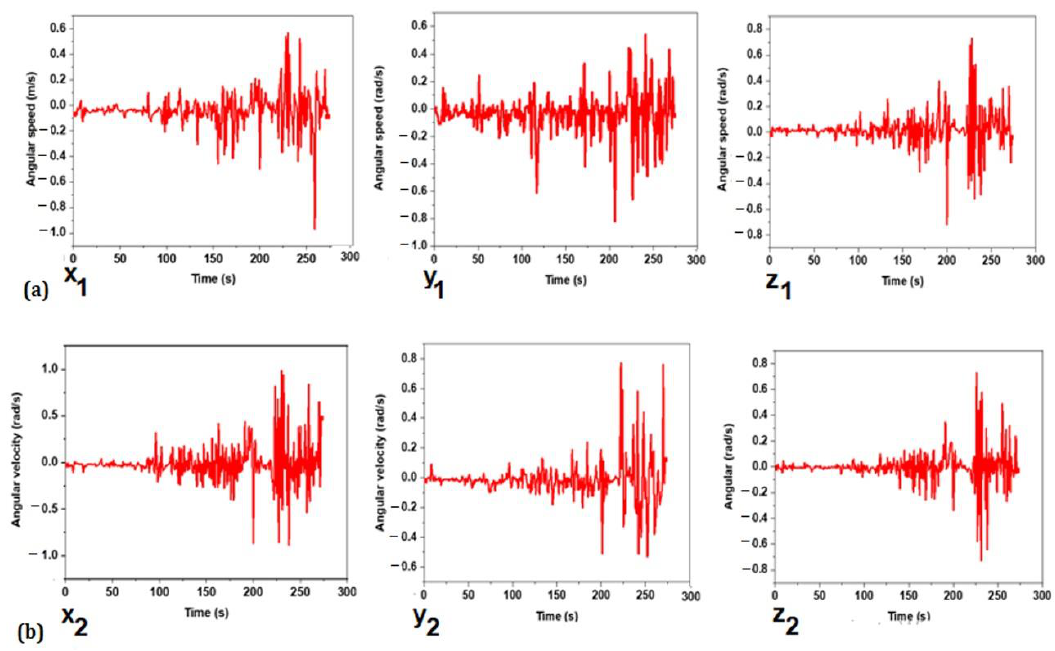
Figure 7. Top sensor ( a ) and bottom sensor ( b ) output angular velocity from the gyroscope. In addition, the cycling movement’s three-axis angular velocity varies substantially.